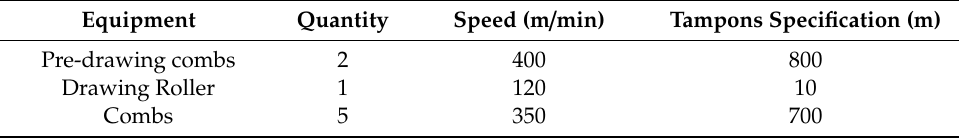
Table 3. Cotton processing parameters.